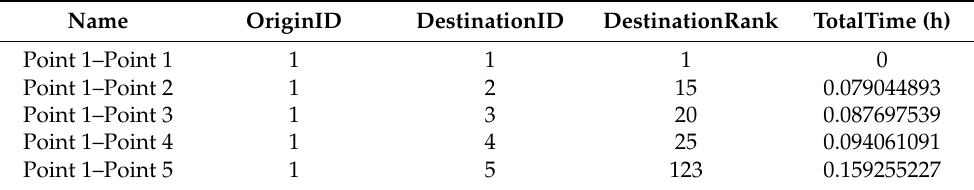
Table 4. Time required for the path between the center points of each grid.